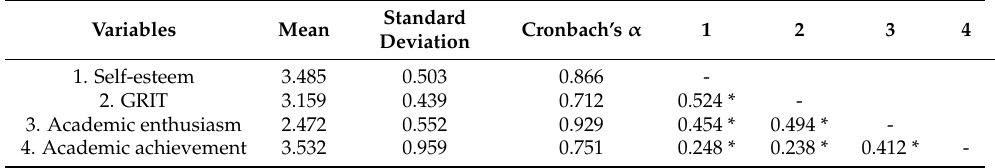
Table 2. Means, standard deviations, Cronbach’s α , and correlations of study